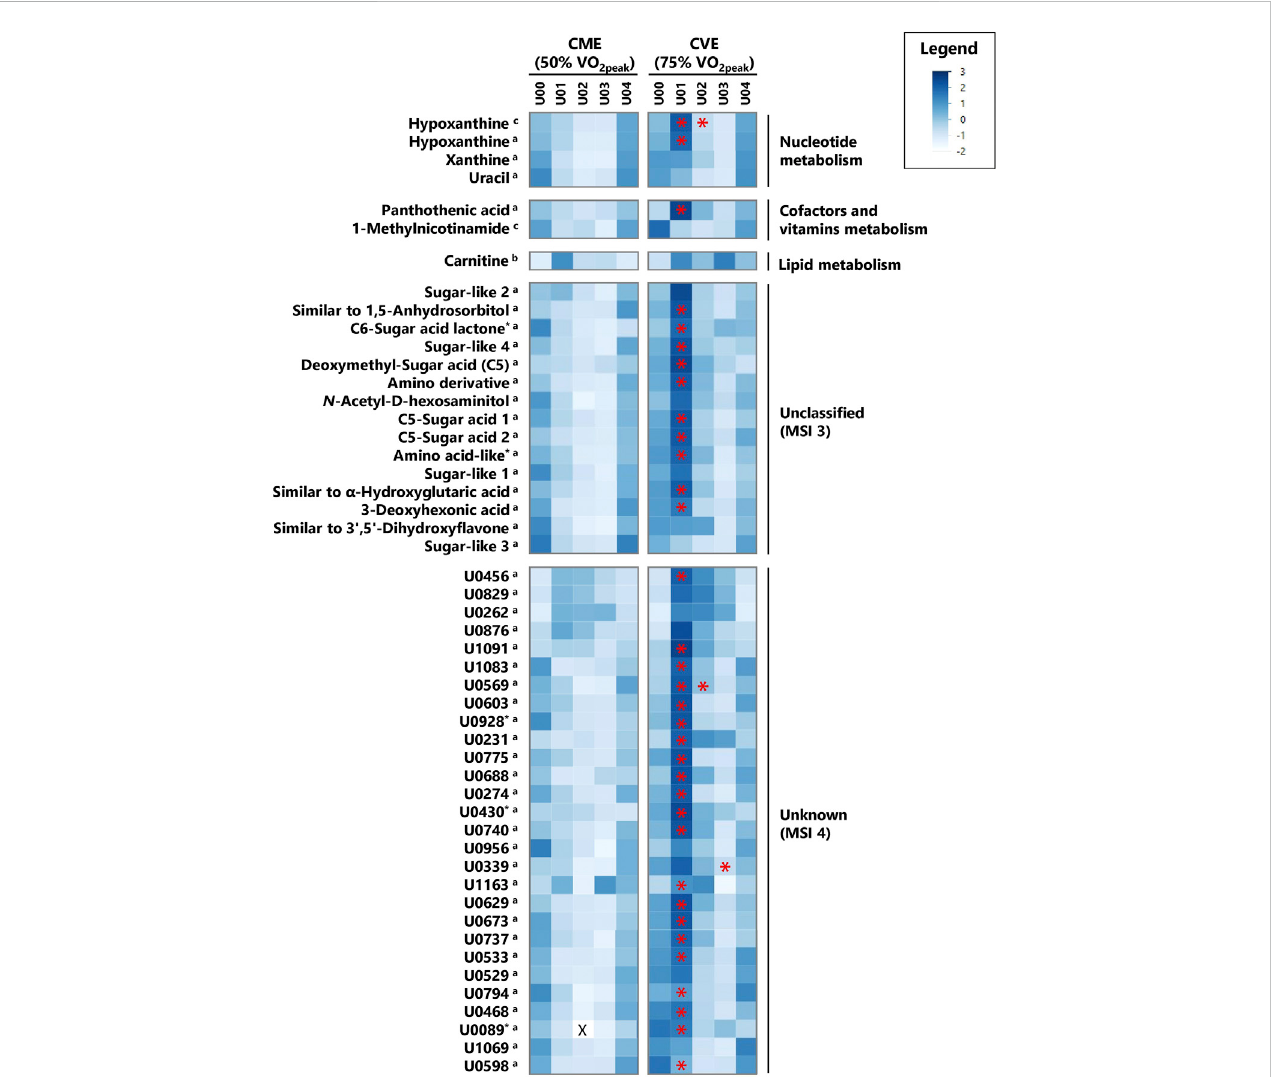
FIGURE 4 Heatmapof z -transformedmedianconcentrationsorsignalintensitiesperurinesampletimepointintheCMEandCVEtrialfor exercise-responsive and/ or intensity-dependent metabolites, sorted by most relevant major metabolic pathways/classes and decreasing median FCs for U01 (CVE)/U00 (CVE) ratio ( continued ). Metabolites with relevant differences between interventions are indicated with a red asterisk. a : GC×GC-MS-detected; b : LC-MS-detected; c : NMR-detected; *: evaluated based on heuristic/visual approach; U: unknown analyte; X: missing